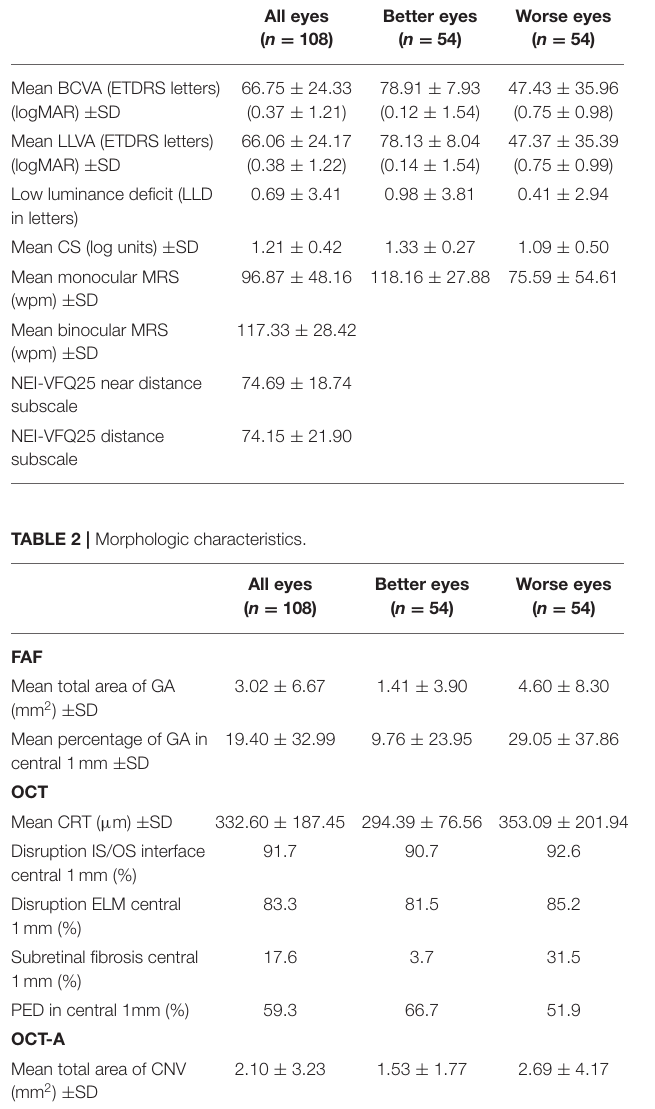
TABLE 1 | Visual assessment.